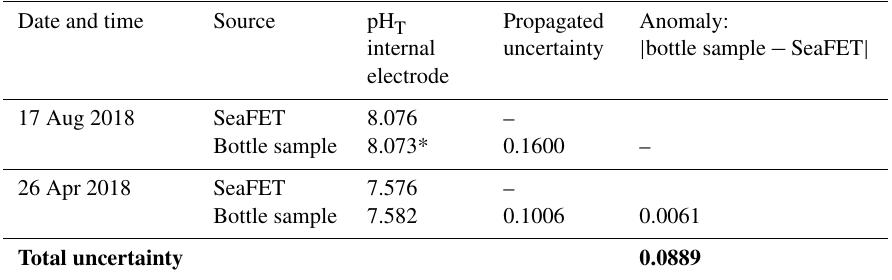
Table 1. Calibration and reference bottle data for SeaFET. Propagated uncertainty, for each bottle, and the calculated total pH uncertainty value as overall average (in